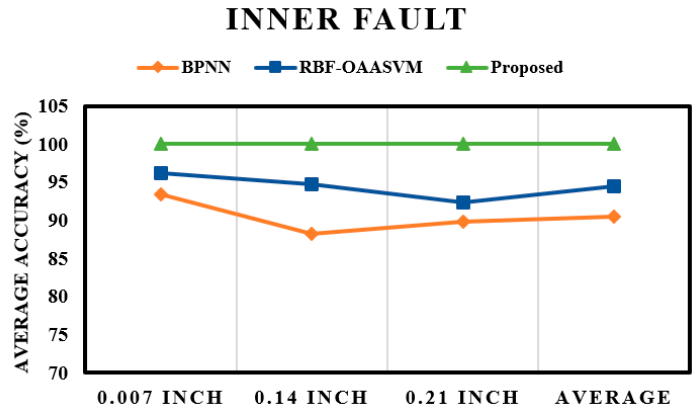
Figure 9. Fault severity prediction in an inner fault.